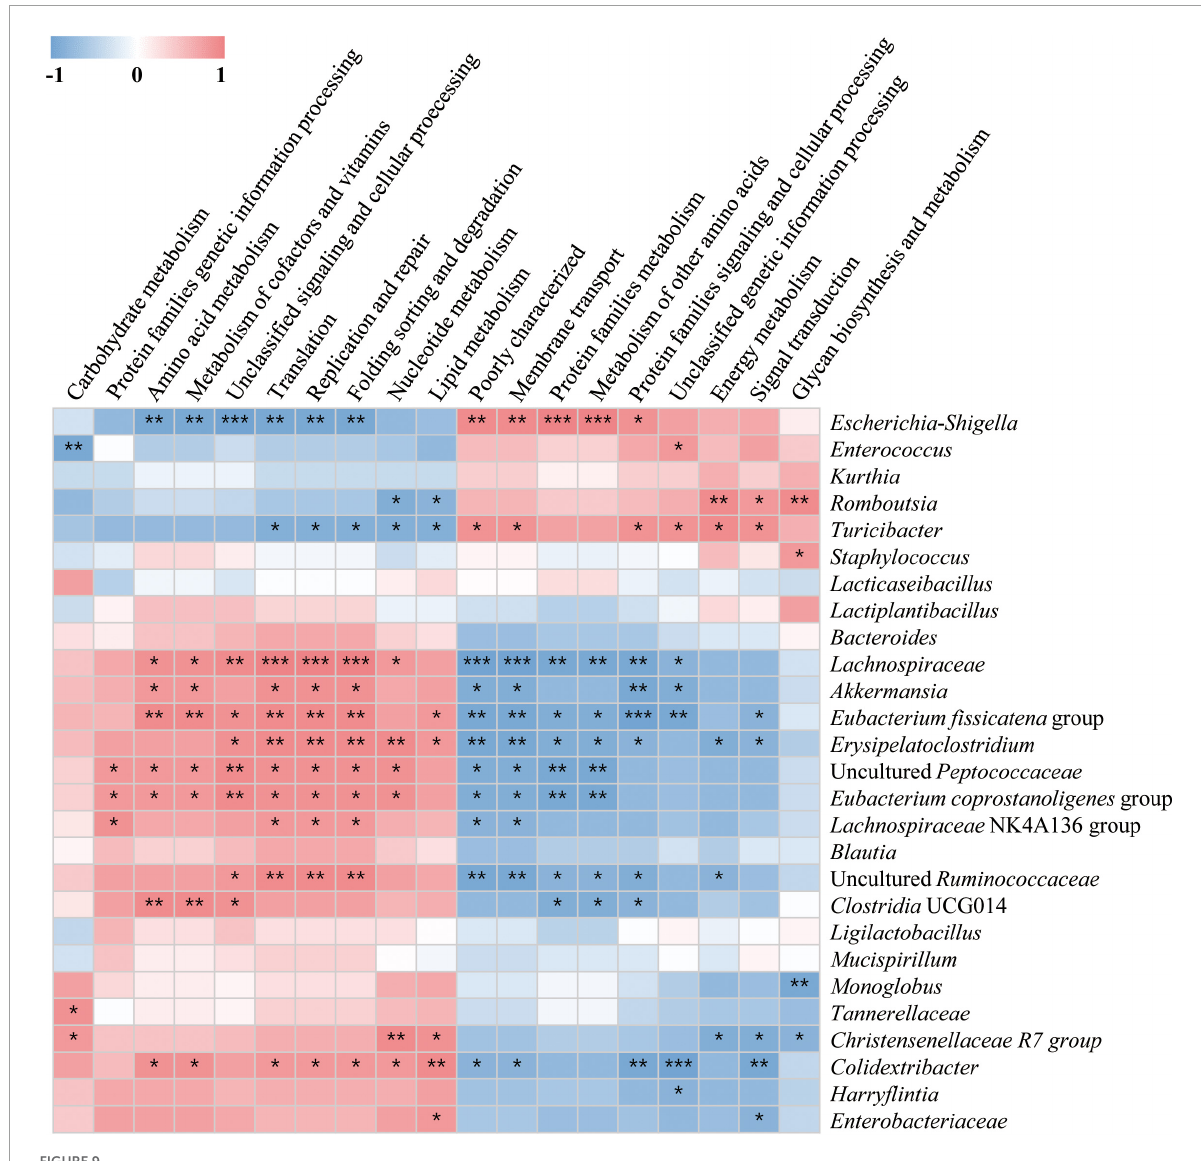
FIGURE9 Associations between altered gut microbial community and predicted KEGG BRITE functional categories. The associations were assessed at the secondary level by performing Spearman’s correlation analysis involving microbial community abundance and functional variables. The intermediate heat map corresponds to the Spearman correlation coefficient, r, with values between − 1 and 1. r < 0 indicates a negative correlation, while r > 0 indicates a positive correlation. * p < 0.05, ** p < 0.01, and *** p <